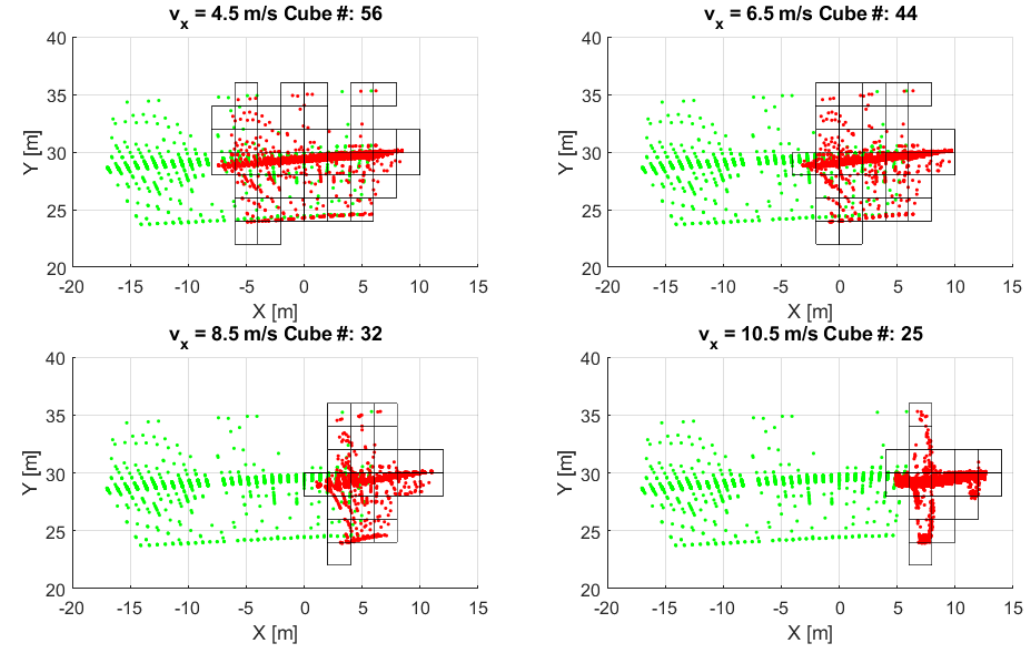
Figure 4. The idea of volume minimization: figures show reconstructions (with red dots) assuming a constant velocity (CV) model with different velocities; green points are the raw data, black rectangles show the occupied cubes, and titles show velocities and number of cubes obtained.